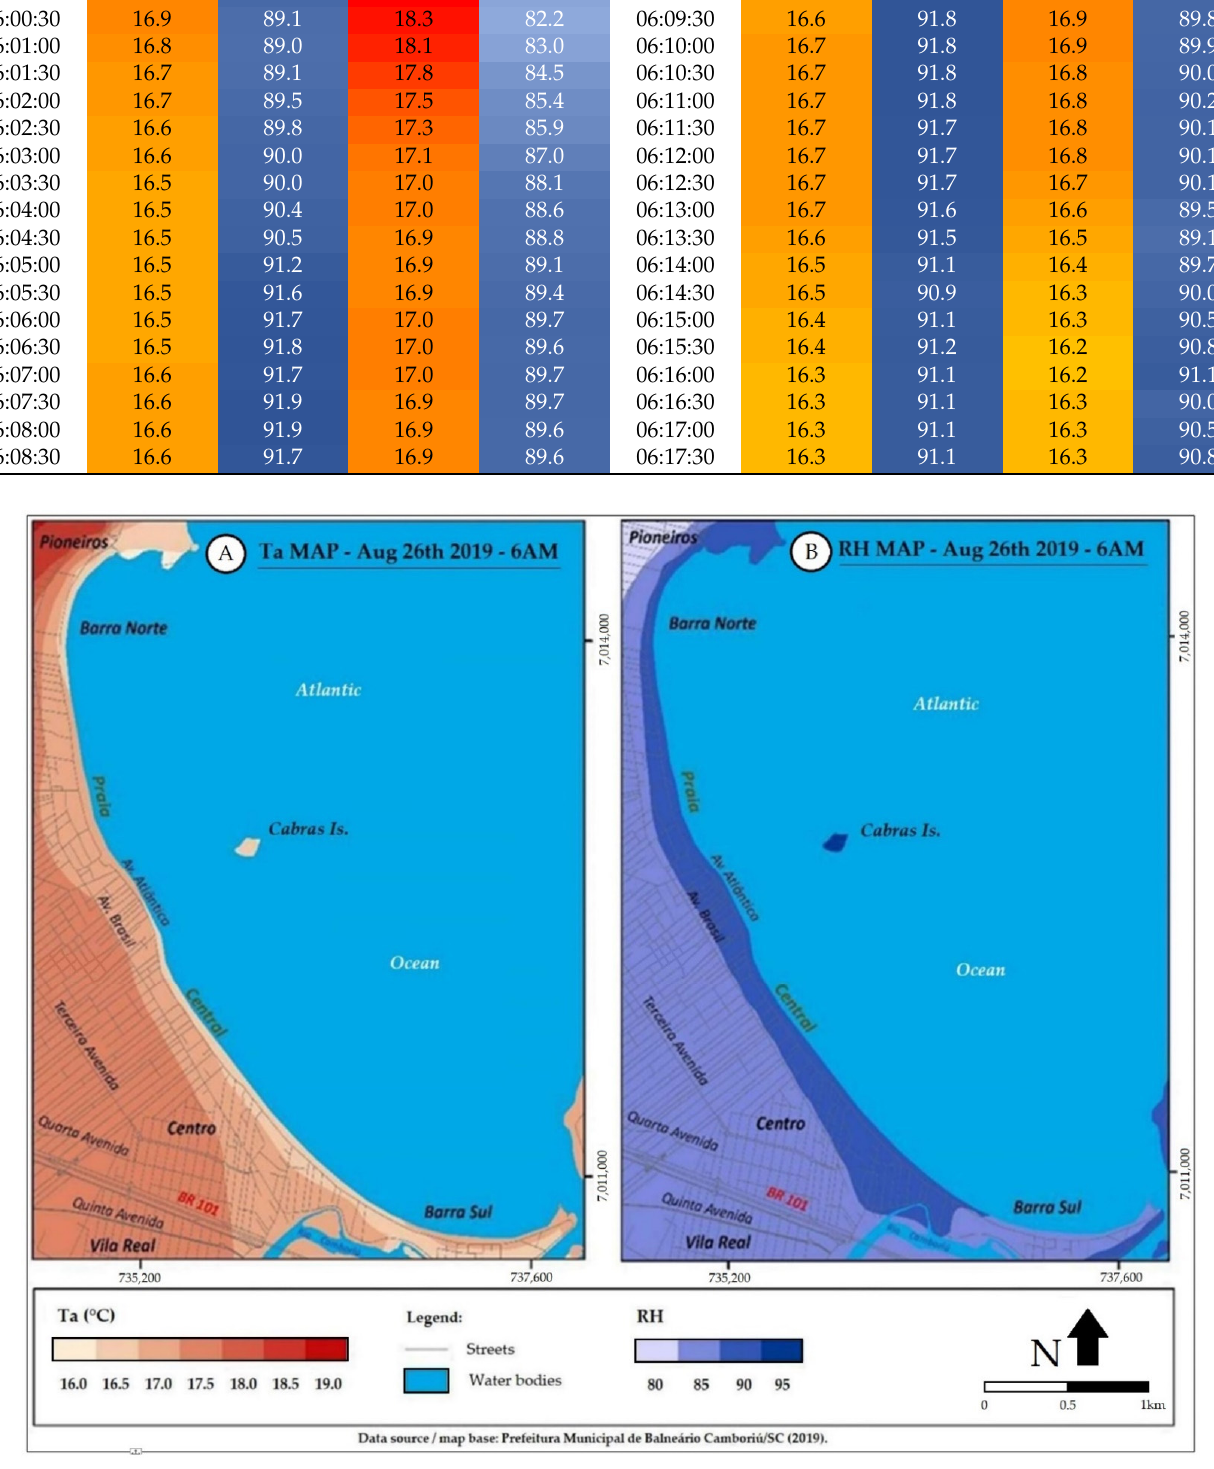
Figure 6. Spatial variability of the Ta ( A ) and RH ( B ) at the waterfront of Balne á rio Cambori ú /SC, on 26 August 2019 Figure 6. S patial variability of the Ta ( A ) and RH ( B ) at the waterfront of Balneário Camboriú/SC, on August 26th, 2019 between 06:00:00 and 06:17:30 (data from Table between 06:00:00 and 06:17:30 (data from Table 2).